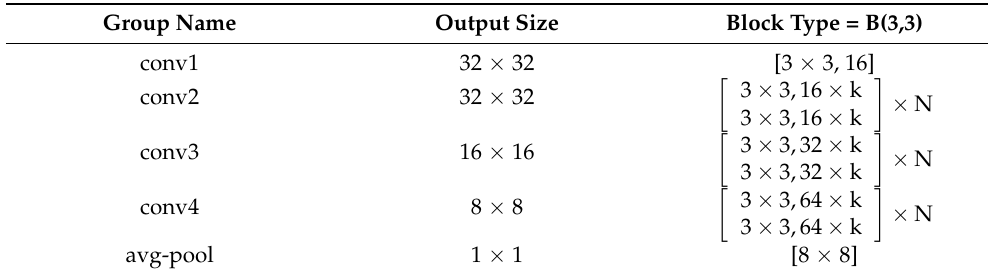
Table 1. Basic structure of Wide Resnet.